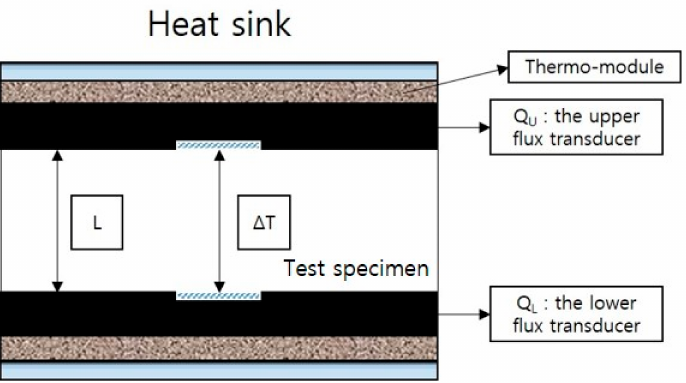
Figure 3. A schematic of thermal conductivity measurement using hot-plate